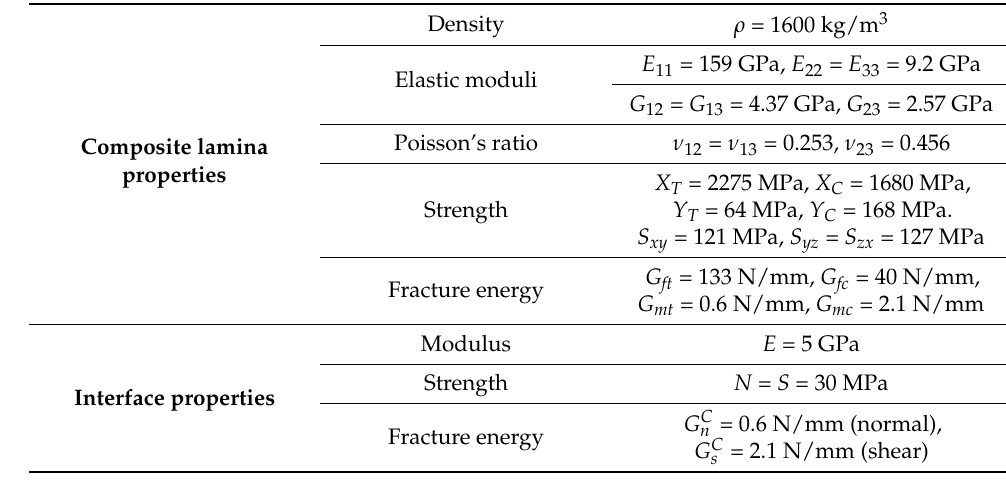
Table 1. Material properties of IM7/977-3 CFRP composites